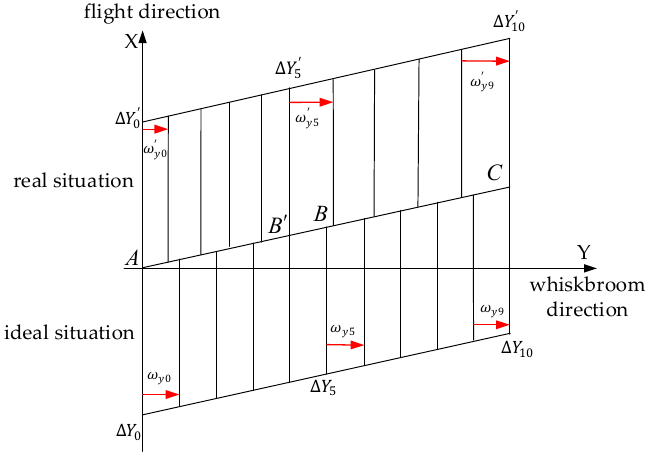
Figure 5. A ground coverage map with equal angles and unequal angles.